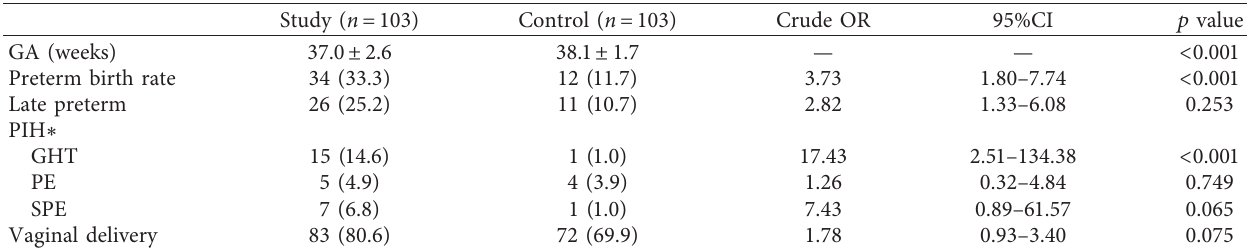
Table 2: Comparison of pregnancy outcomes between the study and control group.